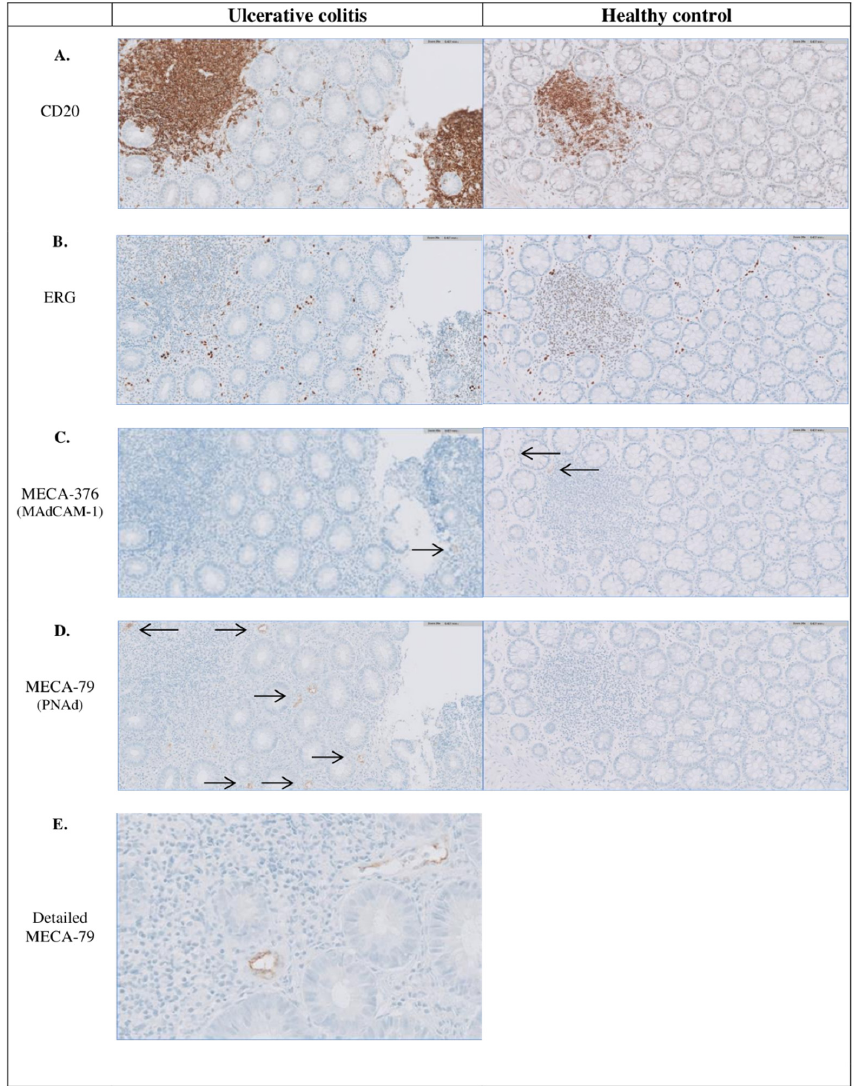
Figure 1. Immunohistochemical staining indicating the presence of follicles and PNAd + and MAdCAM-1 + venules in inflamed colonic tissue of UC patients and non-inflamed colonic tissue of a healthy control. Representative photomicrographs, with a magnification of x 20, of a colonic biopsy from a UC patient with ( A ) CD20 staining indicating B-cells (and follicles), ( B ) ERG staining indicating all venules, ( C ) MECA-367 staining indicating MAdCAM-1 + venules (pointed out with black arrows), ( D ) MECA-76 staining indicating PNAd + venules (pointed out with black arrows) and ( E ) MECA-76 staining in detail with a magnification of x 40. Almost all PNAd + and MAdCAM-1 + venules are located extrafollicular. MAdCAM-1, mucosal vascular addressin cell adhesion molecule-1; PNAd, peripheral node addressin; UC, Ulcerative colitis.